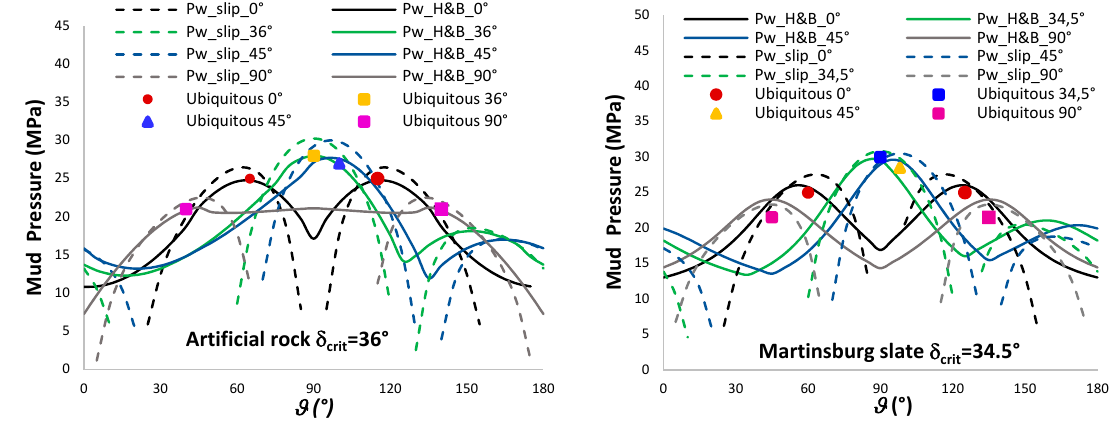
Figure 12. Comparison between the mud pressures calculated with the weakness plane model, Ubiquitous Joint Model and the Hoek and Brown criterion, at different δ . σ MAX = 45 MPa, σ min = 35 MPa, P f = 20 MPa. The out of plane stress used in FLAC is σ II = 40 MPa.